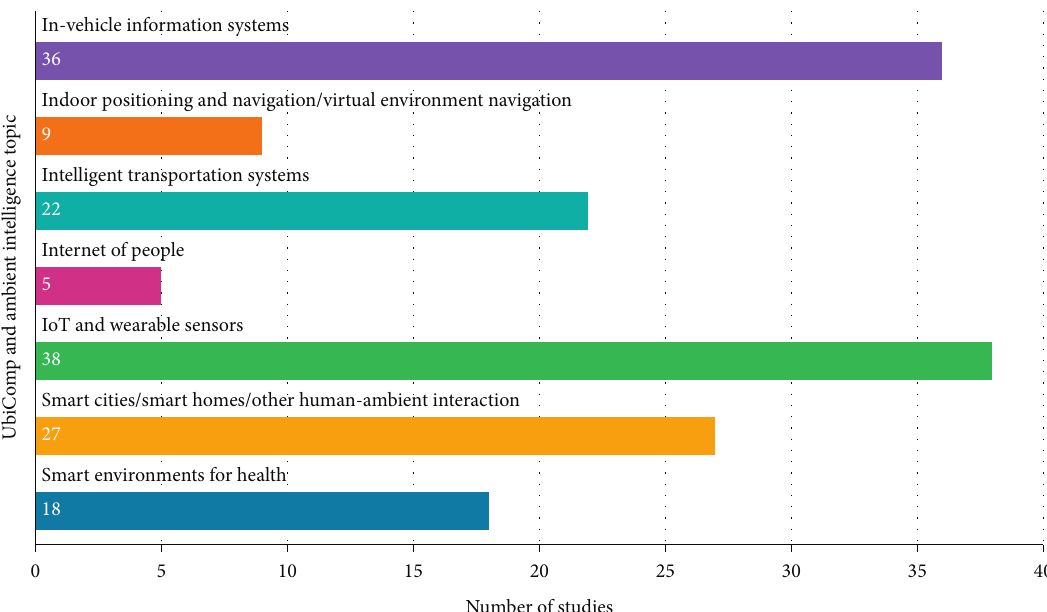
Figure 10: Number of ubiquitous computing and ambient intelligence studies evaluated with standardized questionnaires classified by